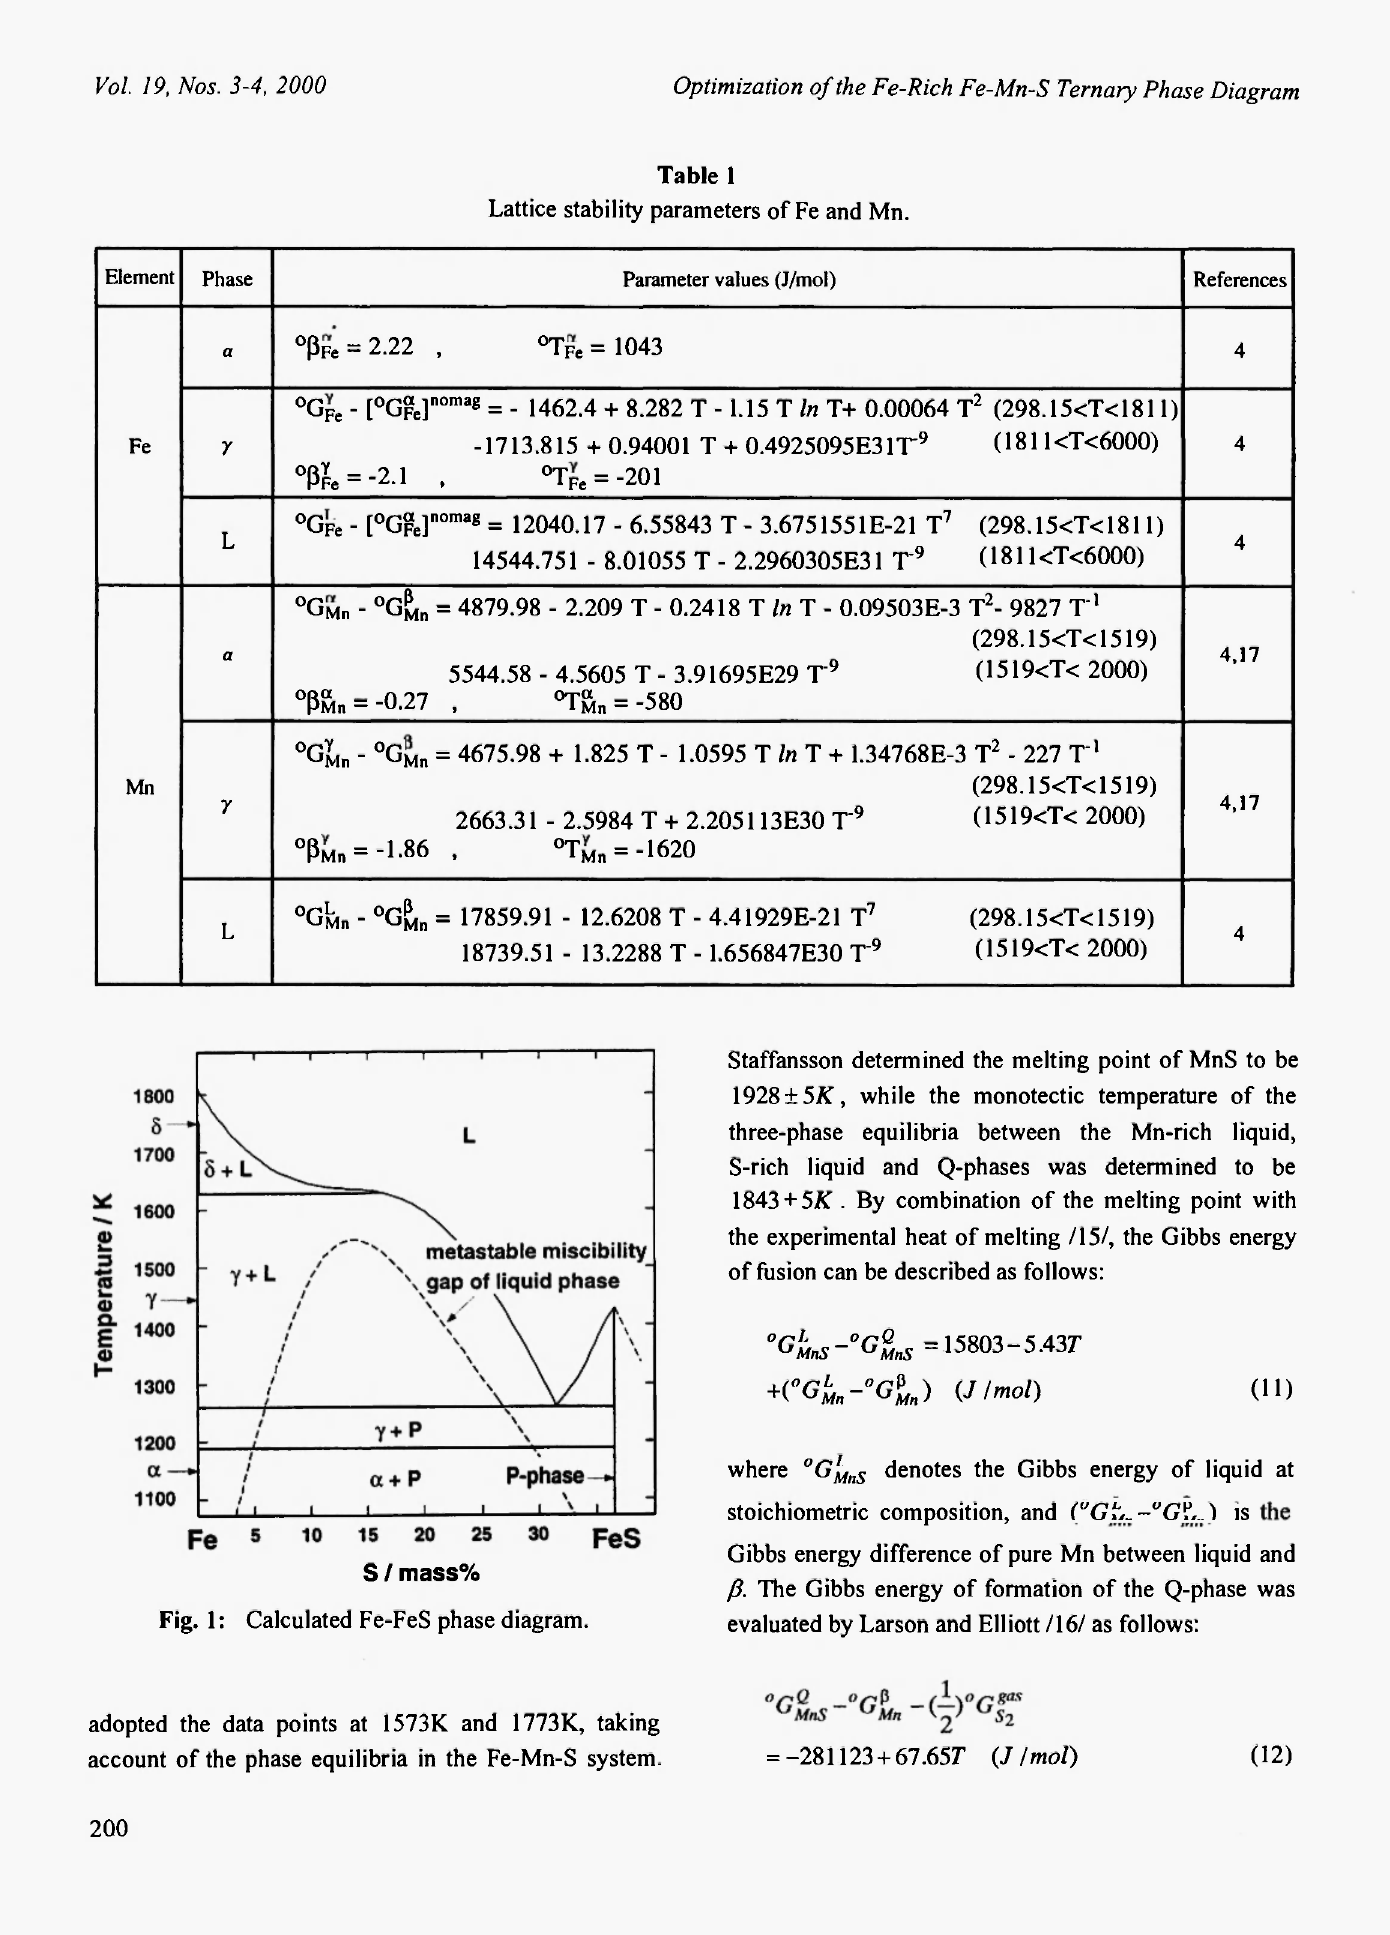
adopted the data points at 1573K and 1773K, taking account of the phase equilibria in the Fe-Mn-S